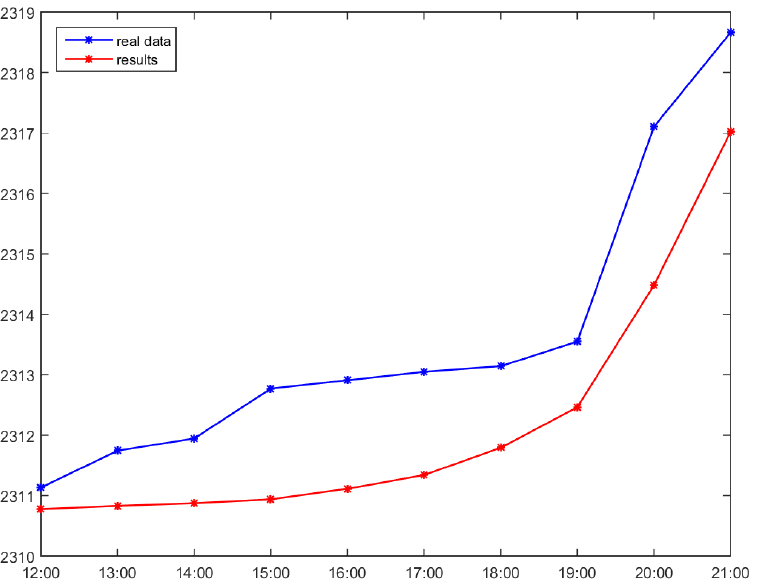
Figure 6. Comparison between the real data and the results obtained from the past-similar-situation substitution method.